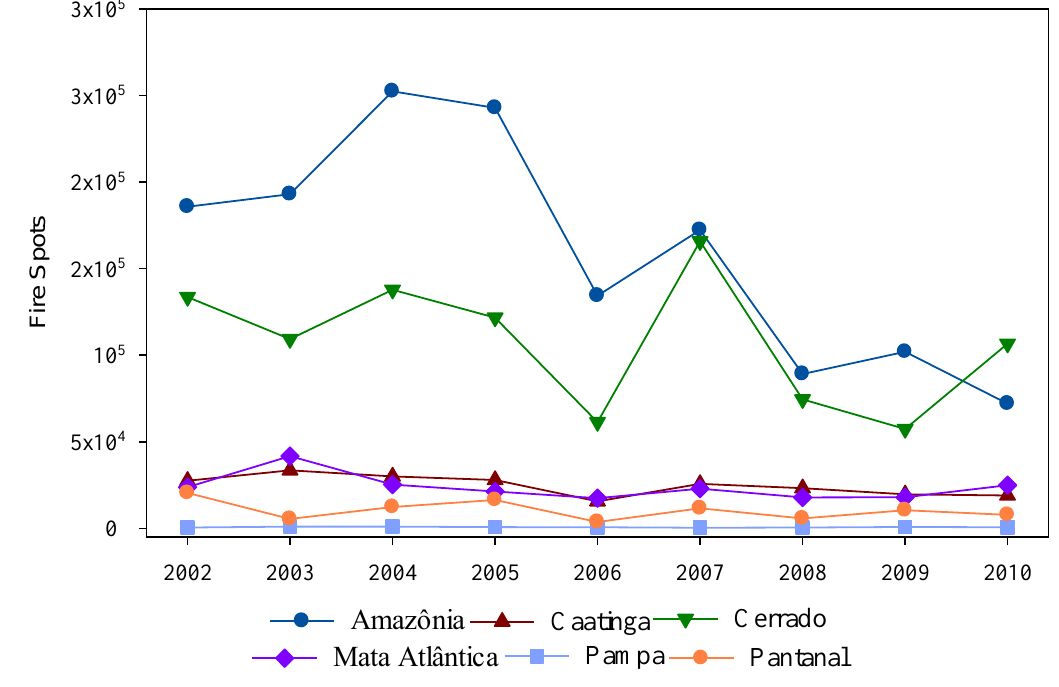
Figure 4. Distribution of thermal anomalies (fire hotspots) in the Brazilian biomes, between 2002 and